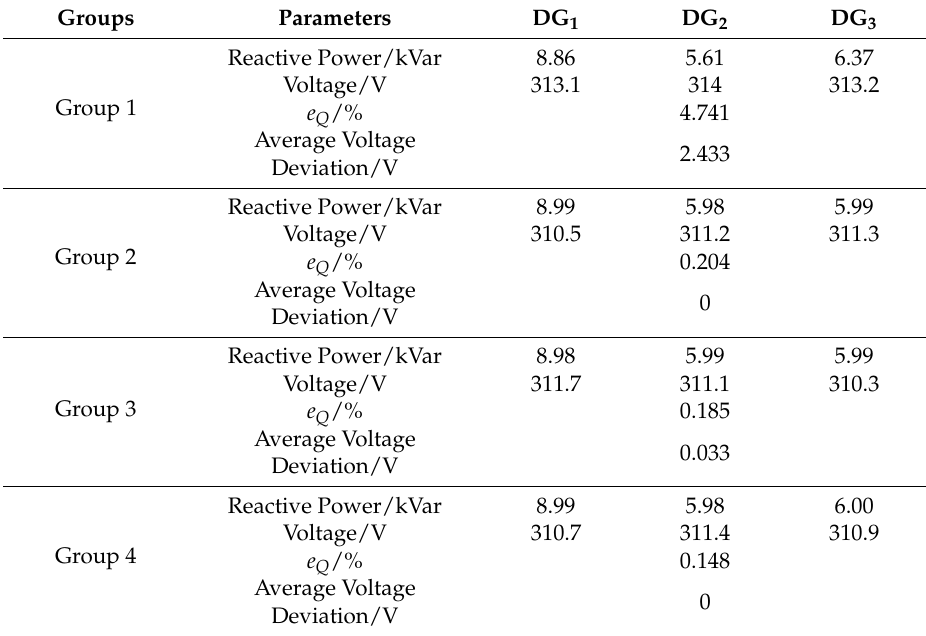
Table 3. System steady-state operation results in different